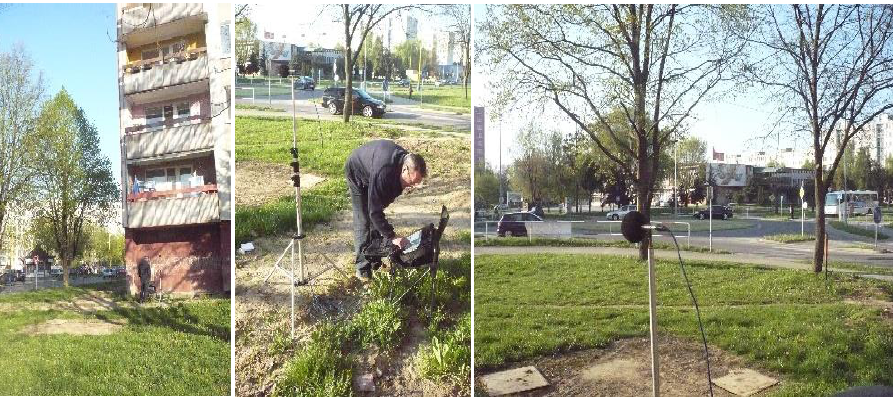
Figure 4. Photos of the measuring set sound analyzer (NOR-121, accuracy Class 0) when measuring roundabout noise emissions at R2.